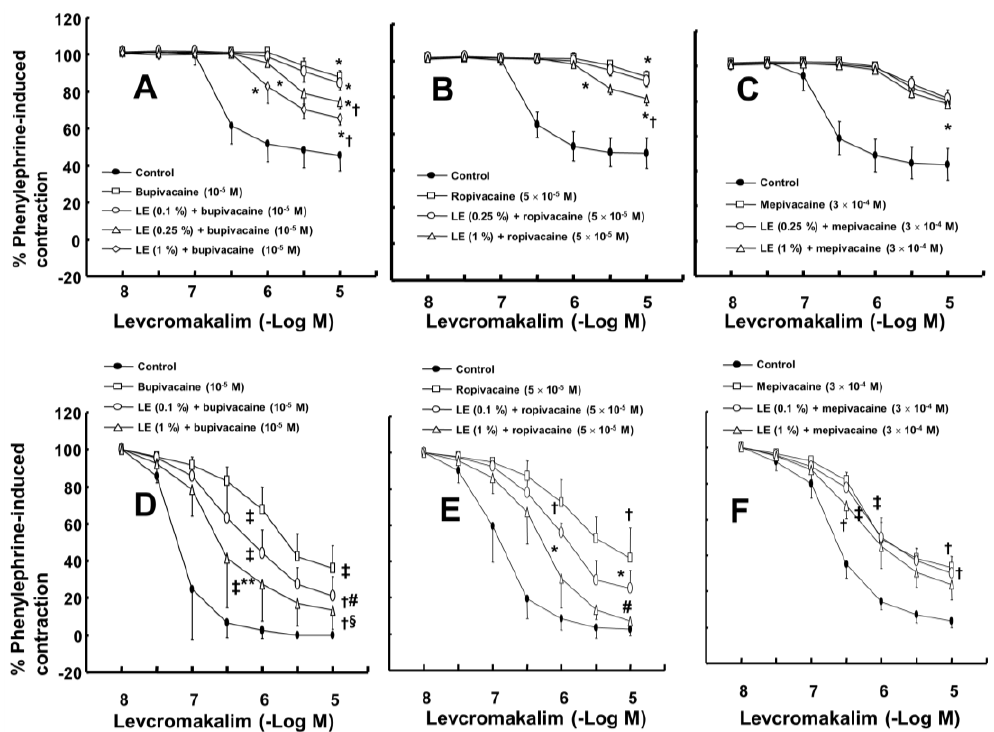
Figure 1. ( A – C ): Effect of lipid emulsion (LE) on the toxic dose of local anesthetic (bupivacaine: ( A ), n = 10; ropivacaine: ( B ), n = 10; mepivacaine: ( C ), n = 10)-mediated reduction of levcromakalim-evoked vasodilation in isolated rat aortas without endothelium. Data are expressed as the mean ± standard deviation and shown as a percentage of the maximal contraction evoked by phenylephrine. Data were analyzed by a one-way analysis of variance (ANOVA) followed by Bonferroni’s multiple comparison test, unpaired Student’s t -test or a Kruskal-Wallis test with Dunn’s multiple comparison test. n indicates the number of isolated rat aortas. Maximal vasodilation induced by levcromakalim (10 − 5 M) or the logarithm (log ED 50 ) of the levcromakalim concentration needed to produce the half maximal vasodilation induced by levcromakalim (10 − 5 M): * p < 0.001 versus control, † p < 0.001 versus bupivacaine or ropivacaine alone. ( D – F ): Effect of LE on the toxic dose of local anesthetic-mediated reduction of levcromakalim-evoked vasodilation in isolated rat mesenteric arteries without endothelium. Data (bupivacaine: ( D ), n = 7; ropivacaine: ( E ), [control n = 6, ropivacaine n = 5, 0.1% LE + ropivacaine: n = 6 and 1% LE + ropivacaine: n = 5]; mepivacaine: ( F ), n = 7) are expressed as the mean ± SD and shown as a percentage of the maximal contraction evoked by phenylephrine. Data were analyzed by one-way ANOVA followed by Bonferroni’s multiple comparison test or a Kruskal-Wallis test with Dunn’s multiple comparison test. n indicates the number of isolated rat mesenteric arteries. Maximal vasodilation induced by levcromakalim (10 − 5 M) or log ED 50 : * p < 0.05, † p < 0.01 and ‡ p < 0.001 versus control. # p < 0.05, § p < 0.01 and ** p < 0.001 versus bupivacaine or ropivacaine